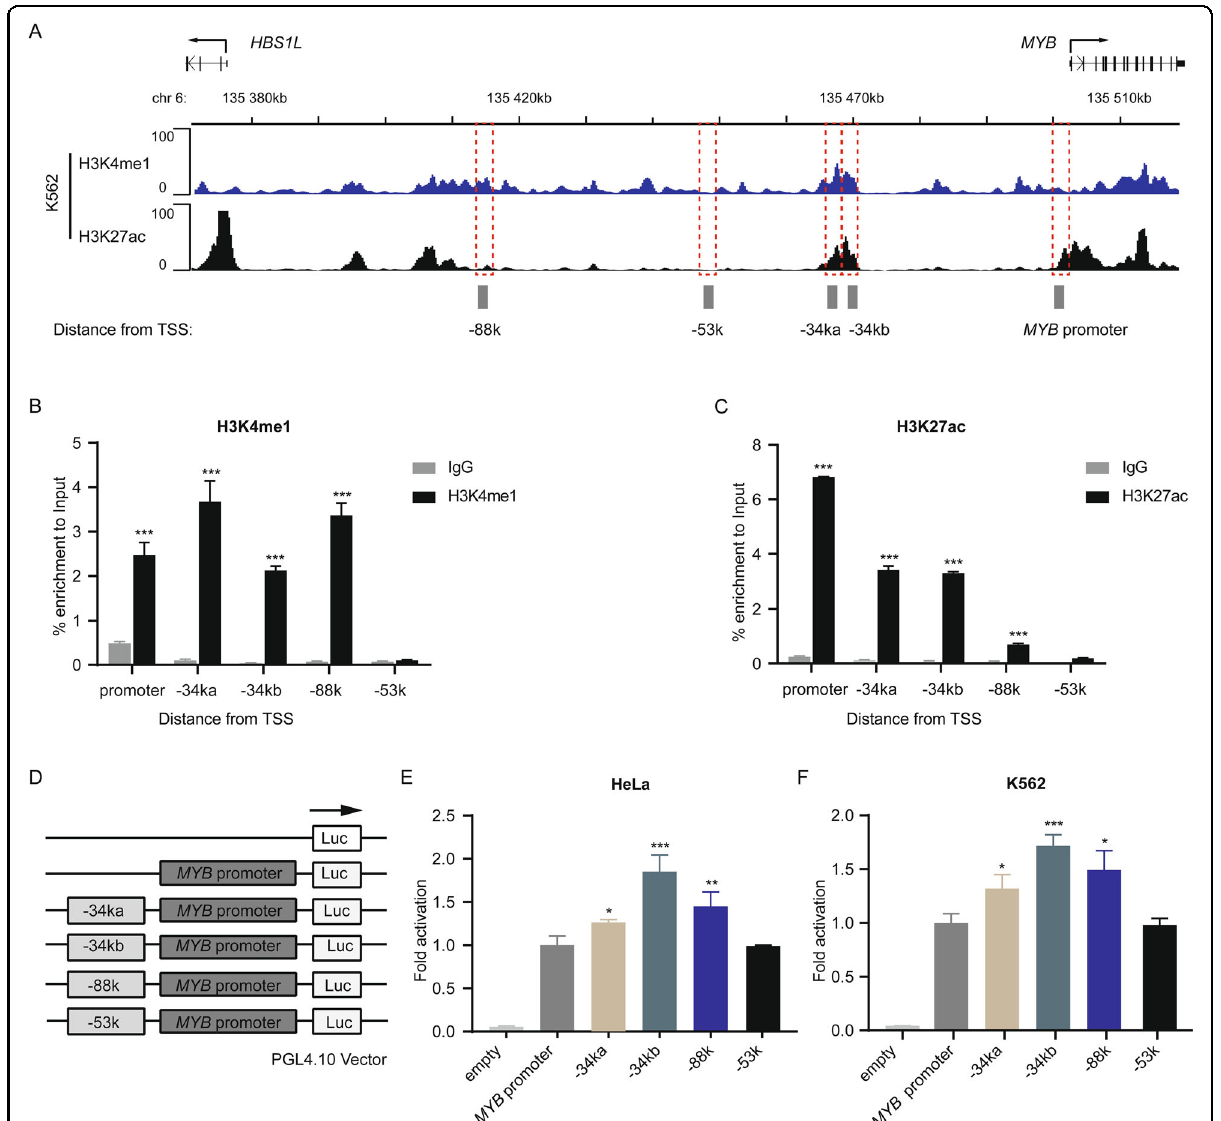
Fig. 2 The − 34k and − 88k regions of MYB are enriched for enhancer features. A Public ChIP-seq data show H3K4me1 and H3K27ac pro fi les in the HBS1L-MYB region, the MYB promoter interaction regions − 34ka, − 34kb, and − 88k are enriched for H3K4me1 and H3K27ac ( − 53k, negative control). The y axis represents sequence tag density. Genome-wide data sets were obtained from the ENCODE consortium and accessed through the WashU Epigenome Browser. B , C ChIP-qPCR was performed to detect the enrichment of H3K4me1 ( B ) and H3K27ac ( C ) at indicated regions in K562 cells. Values are represented as percent input normalized by immunoglobulin G control. D A schematic view of the constructs for enhancer activity assay. E , F Dual-luciferase reporter assay was performed to show the enhancer activity of indicated distal regions in HeLa ( E ) and K562 ( F ) cells. The pGL4.10- MYB -promoter was used as control. Luciferase signals were normalized to renilla signals. Data are represented as mean ± SD of three independent experiments, and P values are calculated using Student ’ s t -test (* P < 0.05; ** P < 0.01; *** P < 0.001) in B , C , E , and F